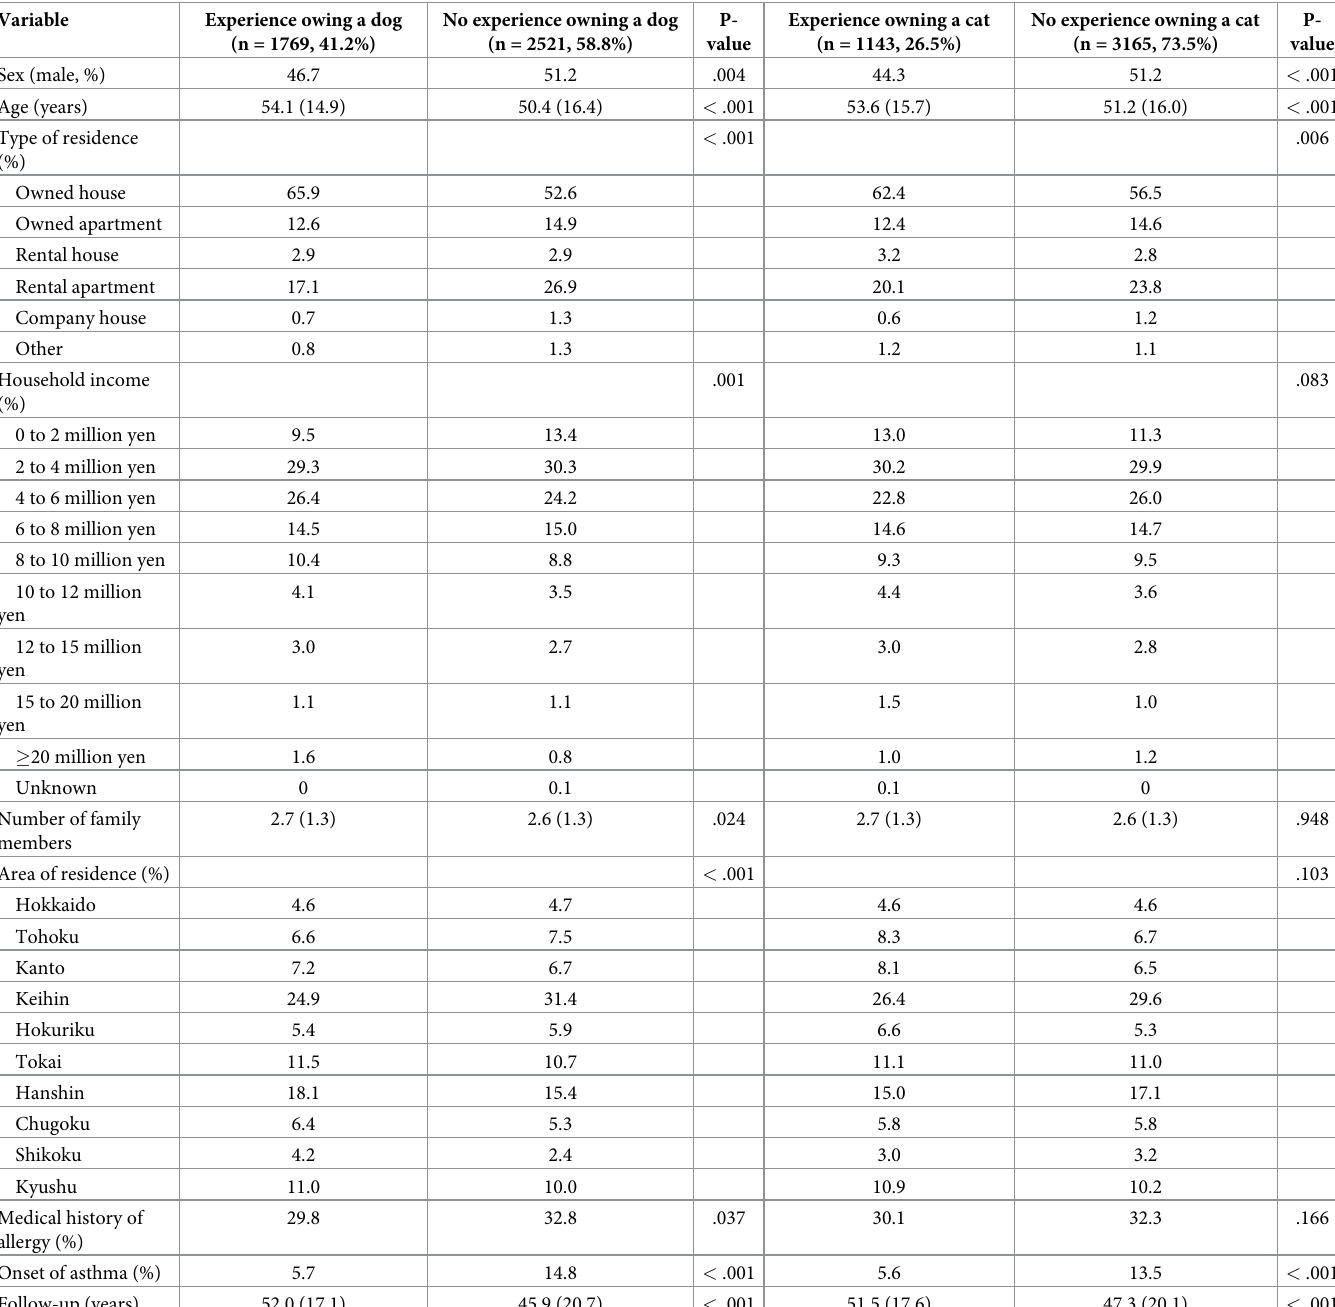
Table 1. Sociodemographic characteristics of dog/cat owners and non-pet owners in Japan.